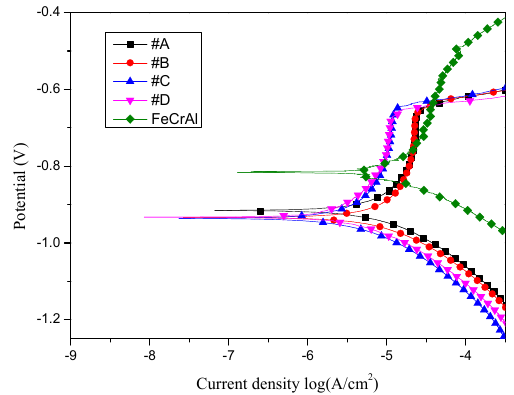
Figure 7. Potentiodynamic polarization curves of the composite coatings and FeCrAl coating. Table 4. Potentiodynamic polarization parameters of the sprayed coatings.